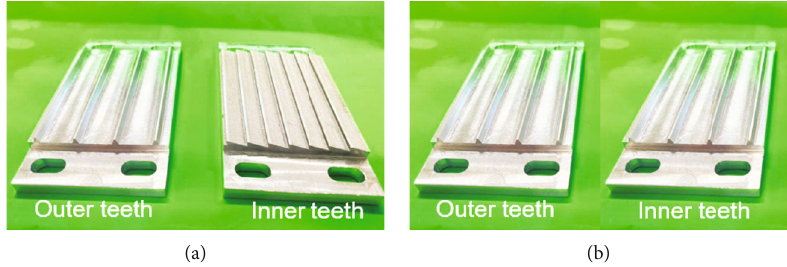
Figure 9: Detail drawing of simpli fi ed (a) bionic and (b) traditional crimping